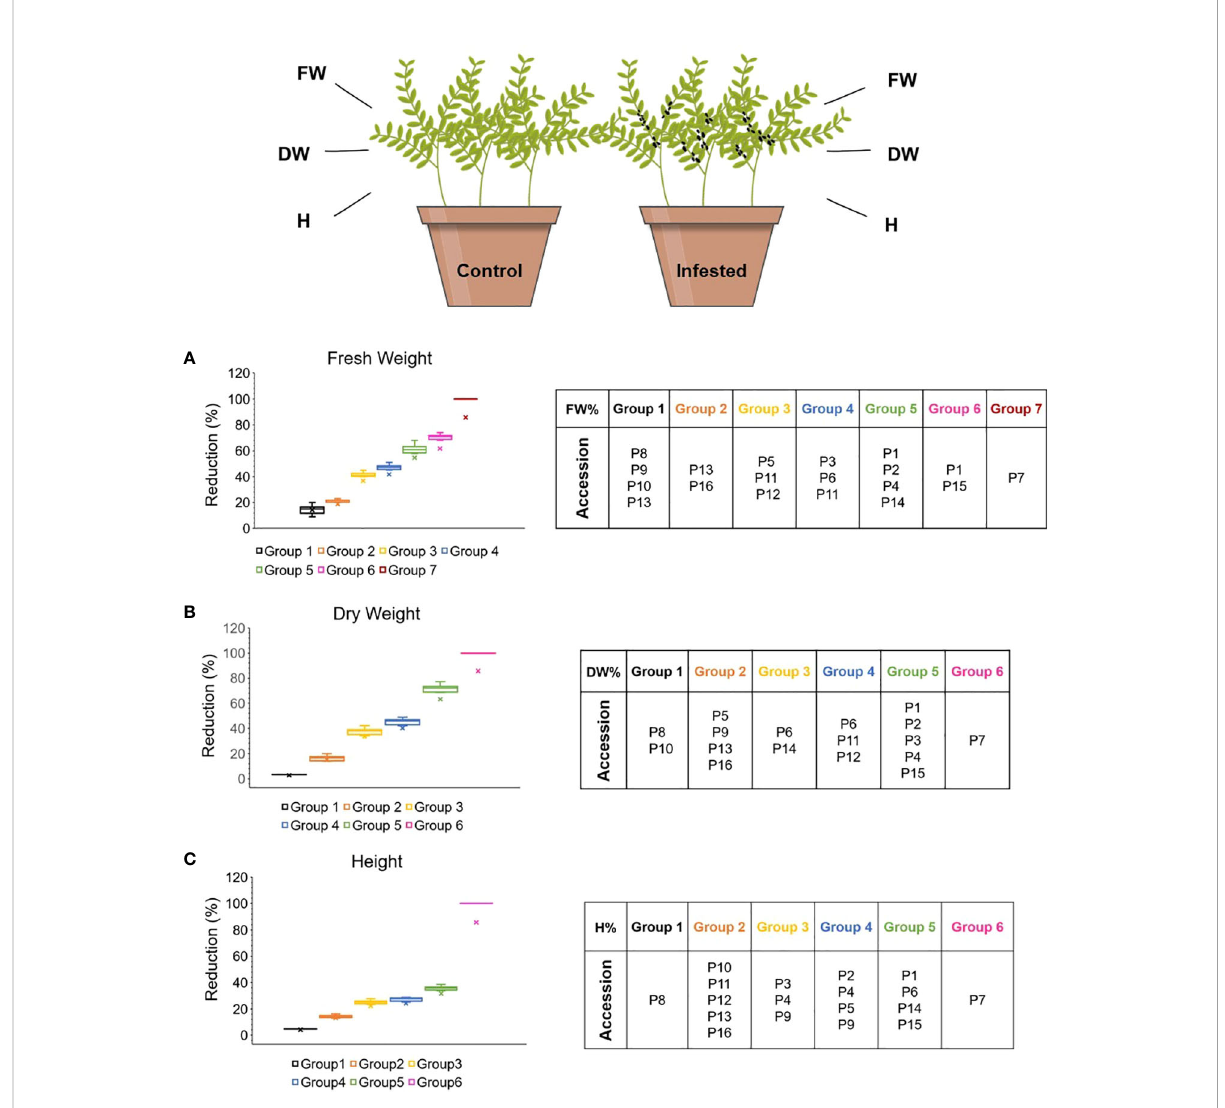
FIGURE 2 Effect of aphid herbivory on the (A) FW, (B) DW, (C) H reduction (%) of the different lentil accessions 12dpi. The accessions were assigned to different groups based on their post infestation performance, according to Tukey ’ s HSD ( p <0.05). The fi gure was created with